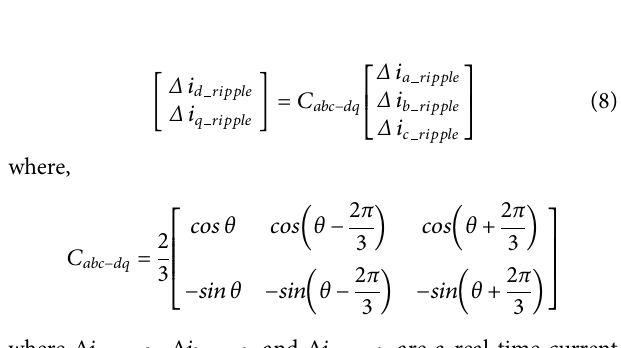
FIGURE 5 | Control diagram of